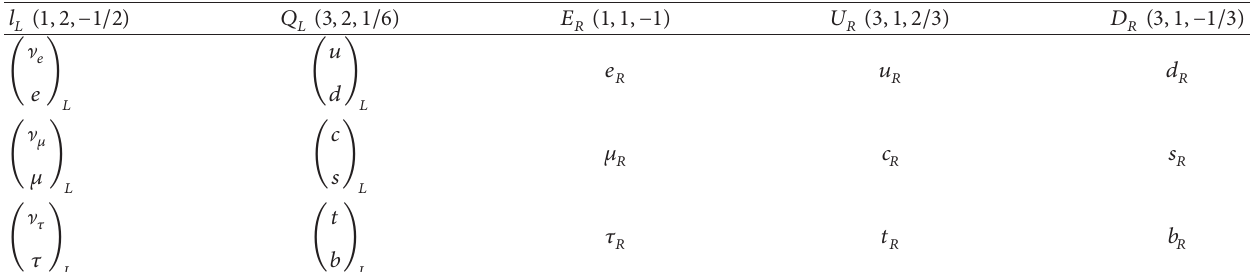
Table 2: Particle content of the